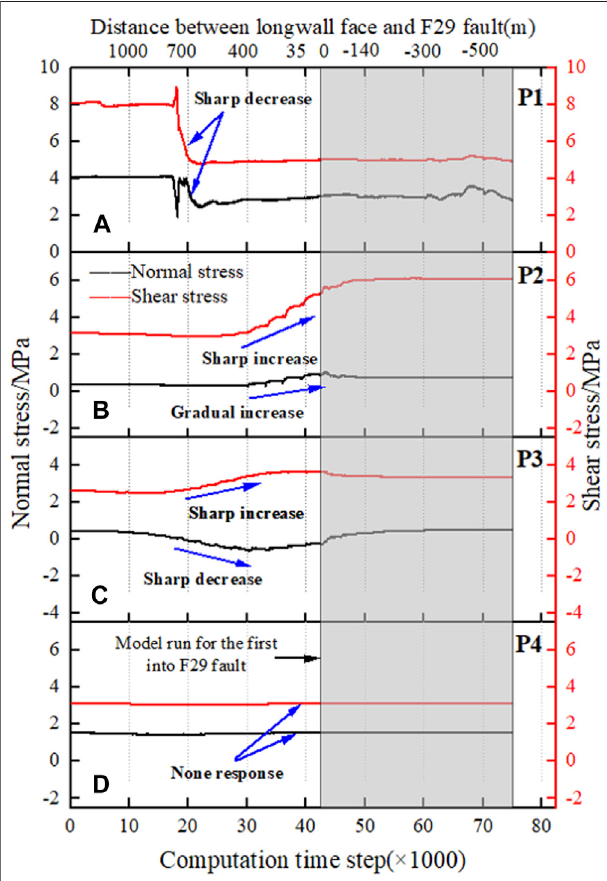
FIGURE7| Changelawsofnormalstressandshearstresswithworking face advance. (A) P1; (B) P2; (C) P3; (D) P4.